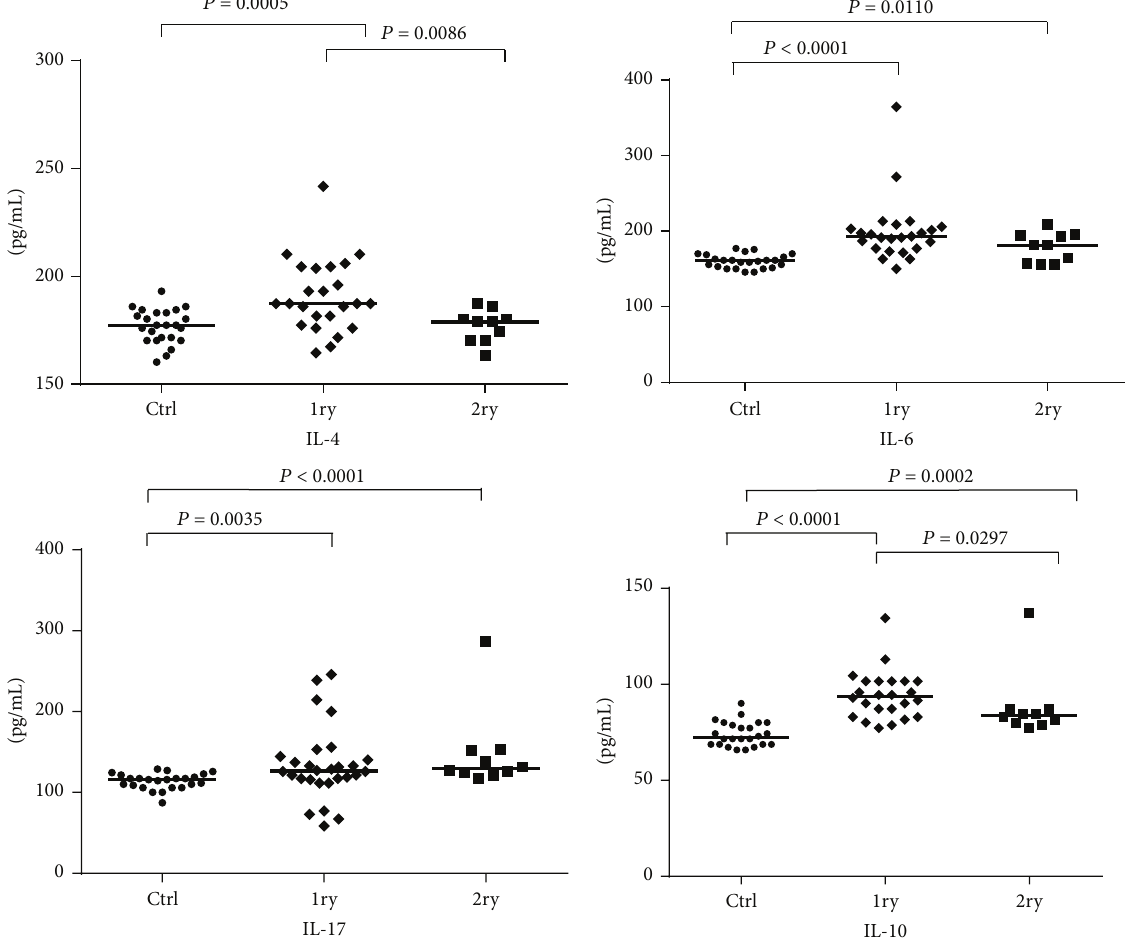
Figure 4: IL-4, IL-6, IL-10, and IL-17 levels in sera obtained from individuals with primary or secondary Leishmania infections and from noninfected controls. Cytokine levels (pg/mL) were calculated for each serum sample. Means (horizontal lines) are shown for each